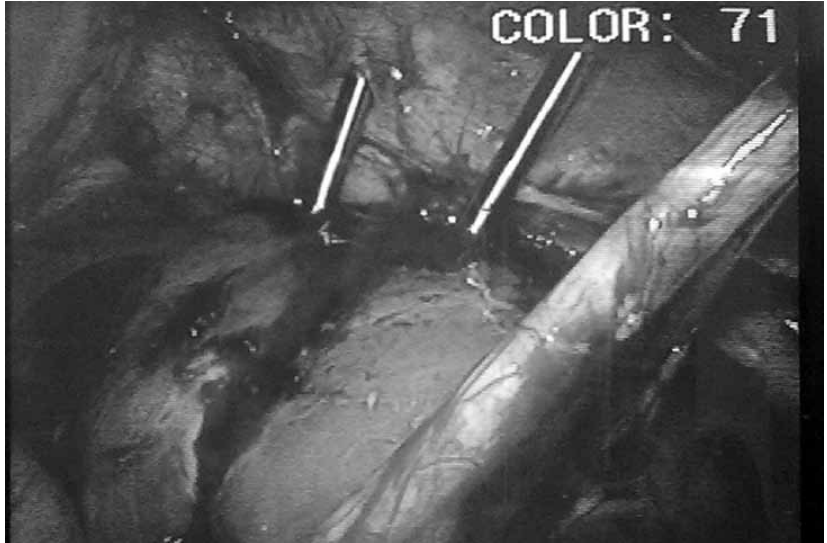
Figure 2 - Temperature probes in the cortical and medullary tissue of the